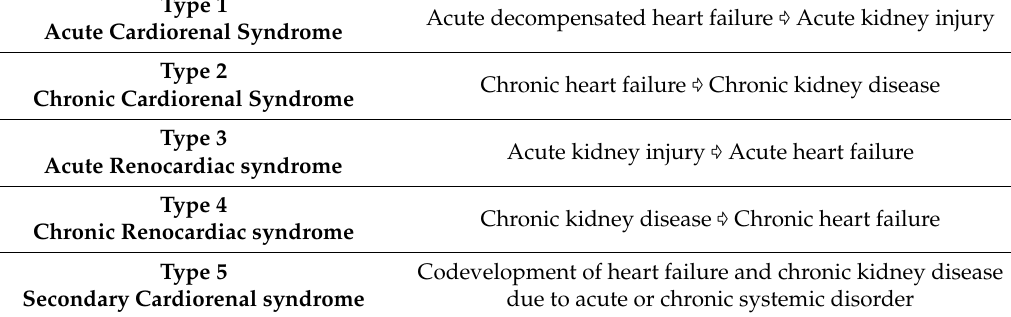
Table 1. Types of Cardiorenal